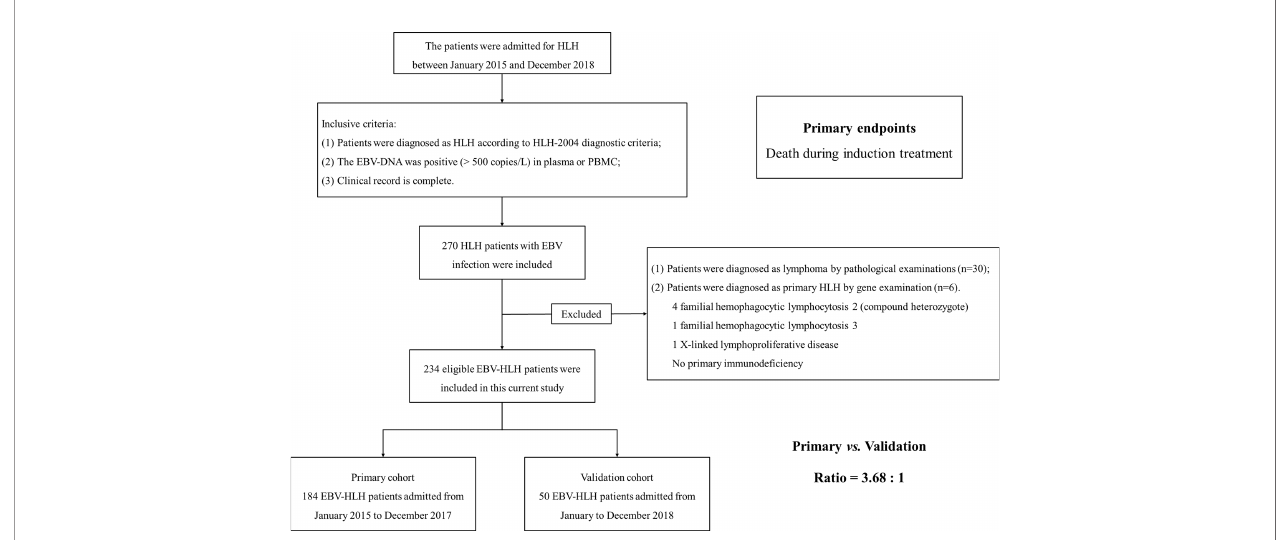
FIGURE 1 | The fl ow chart of patient enrollment. We retrospectively reviewed the patients admitted to our medical institution from January 2015 to December 2018. Finally, 234 patients were enrolled into this current study. We set patients admitted from January 2015 to December 2017 as primary cohort and patients admitted from January to December 2018 as validation cohort. The ratio of primary cohort to validation cohort was approximately